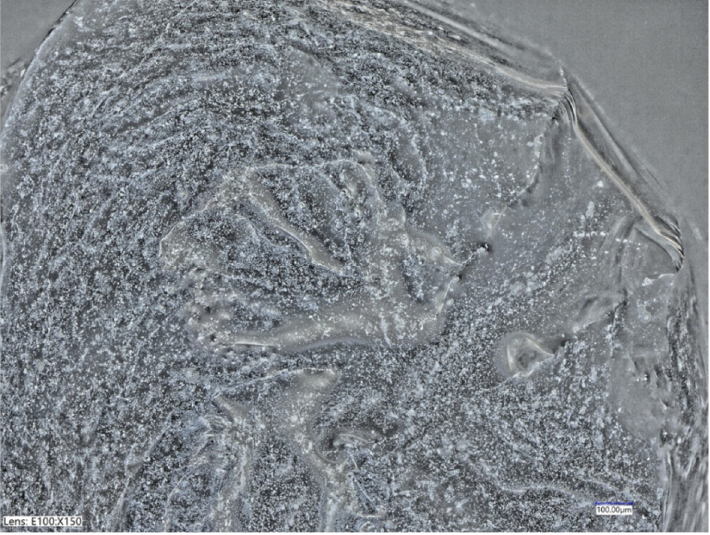
Figure 2. SAP hydrogel grain covered with nano-grains of titanium dioxide used in the study.